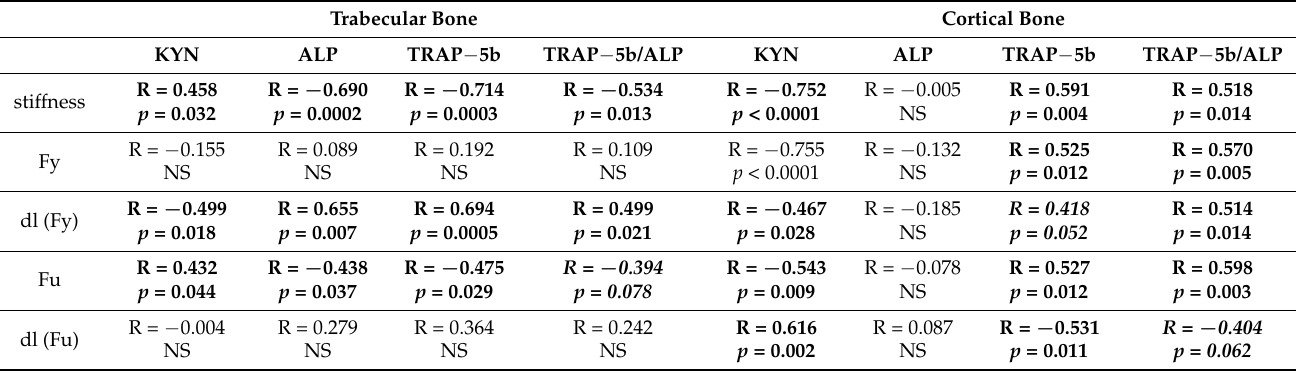
The statistically significant changes are bolded, and tendency to correlation are marked in italics. Abbreviations: NS = non statistically significant; Fy = yield load; dl (Fy) = displacement at yield load; Fu = ultimate load; dl (Fu) = displacement at ultimate load; ALP =